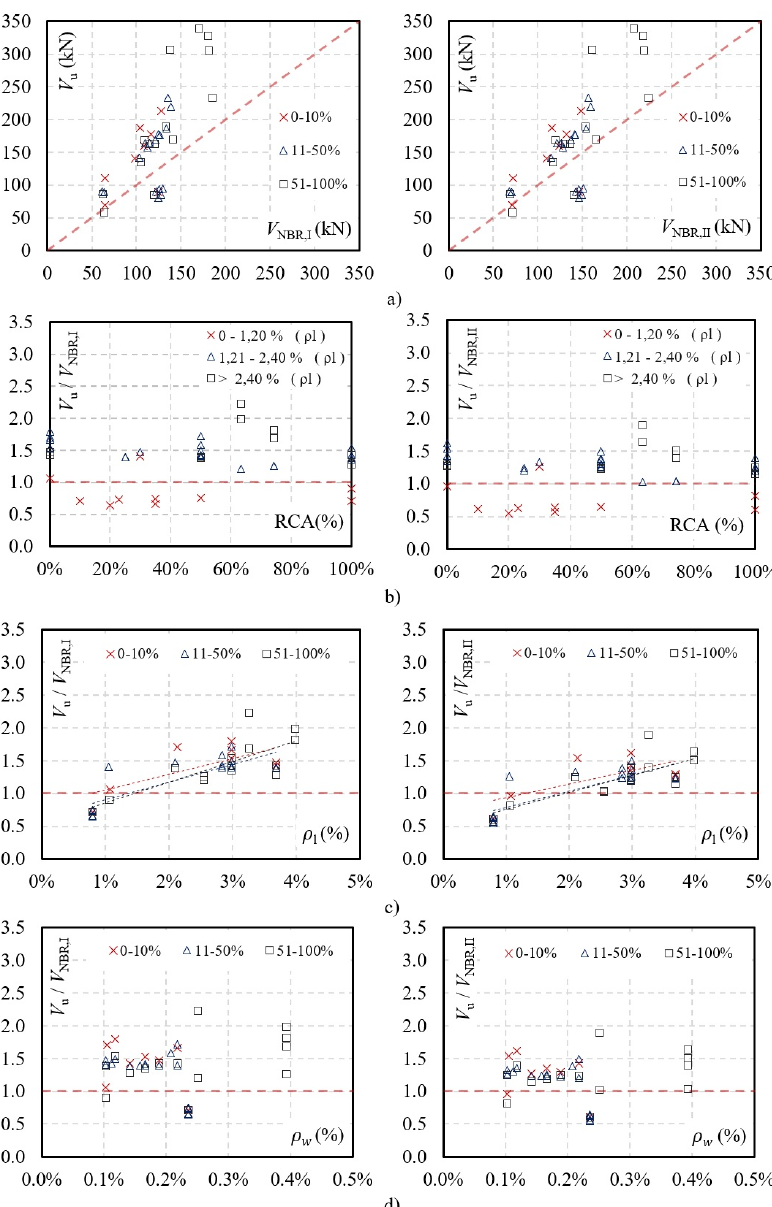
Figure 8. Comparison between the experimental and theoretical for the database of beams with